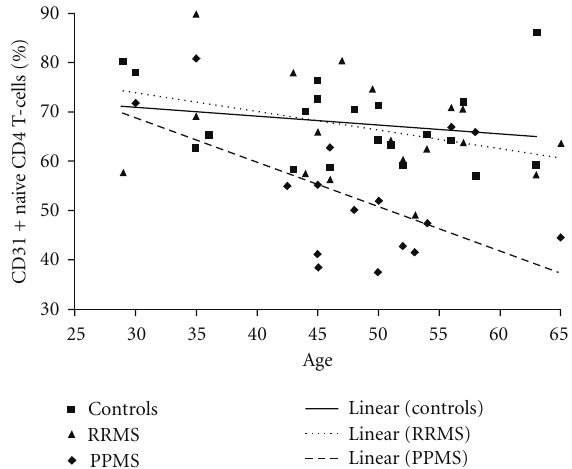
Figure 2: Naive CD4 T-cell expression of CD31. The proportion of na¨ıve CD4 T-cells expressing CD31 showed a significant decrease with age only in PPMS ( P = 0 .